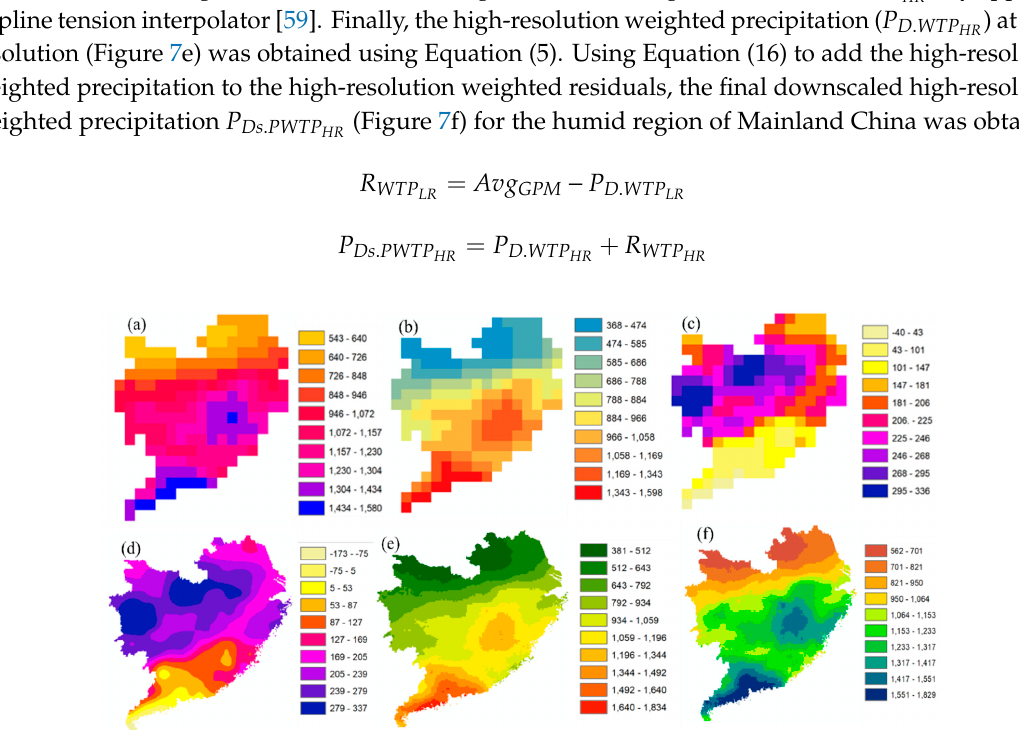
Figure 7. Stepwise downscaling process to predict the high-resolution multitemporal weighted precipitation: ( a ) the GPM-based average multitemporal precipitation at 0.75° resolution; ( b ) the EDBF-based weighted precipitation at 0.75° resolution; ( c ) the low-resolution weighted residuals at 0.75° resolution generated from the difference between ( a ) and ( b ); ( d ) the high-resolution weighted residuals at 0.05° resolution generated by interpolating ( c ) via Spline Interpolation; ( e ) the EDBF- based high-resolution weighted precipitation at 0.05° resolution; and ( f ) the final high-resolution downscaled multitemporal weighted precipitation, at 0.05° resolution, as a product of adding ( d ) into ( e ), respectively.